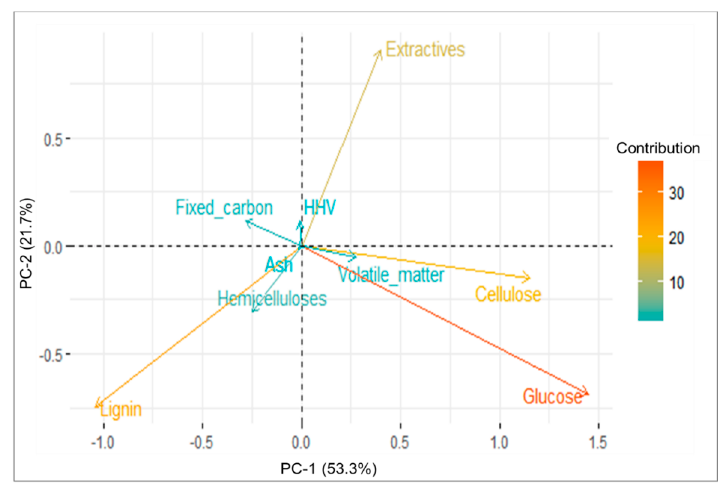
Figure 6. Loadings plot of the first two principal components.